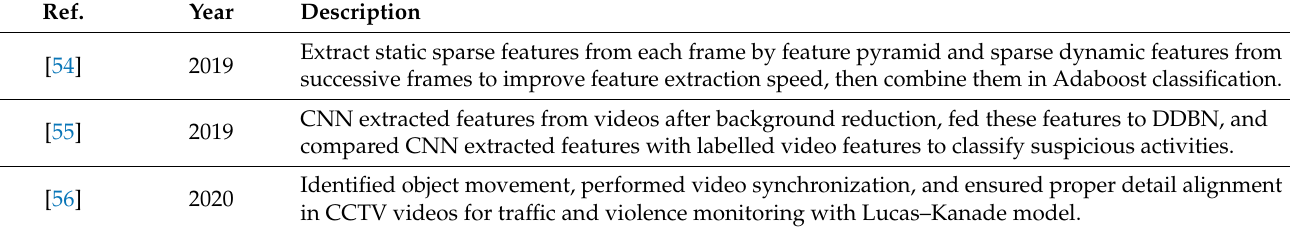
Table 3. Summary of literature on